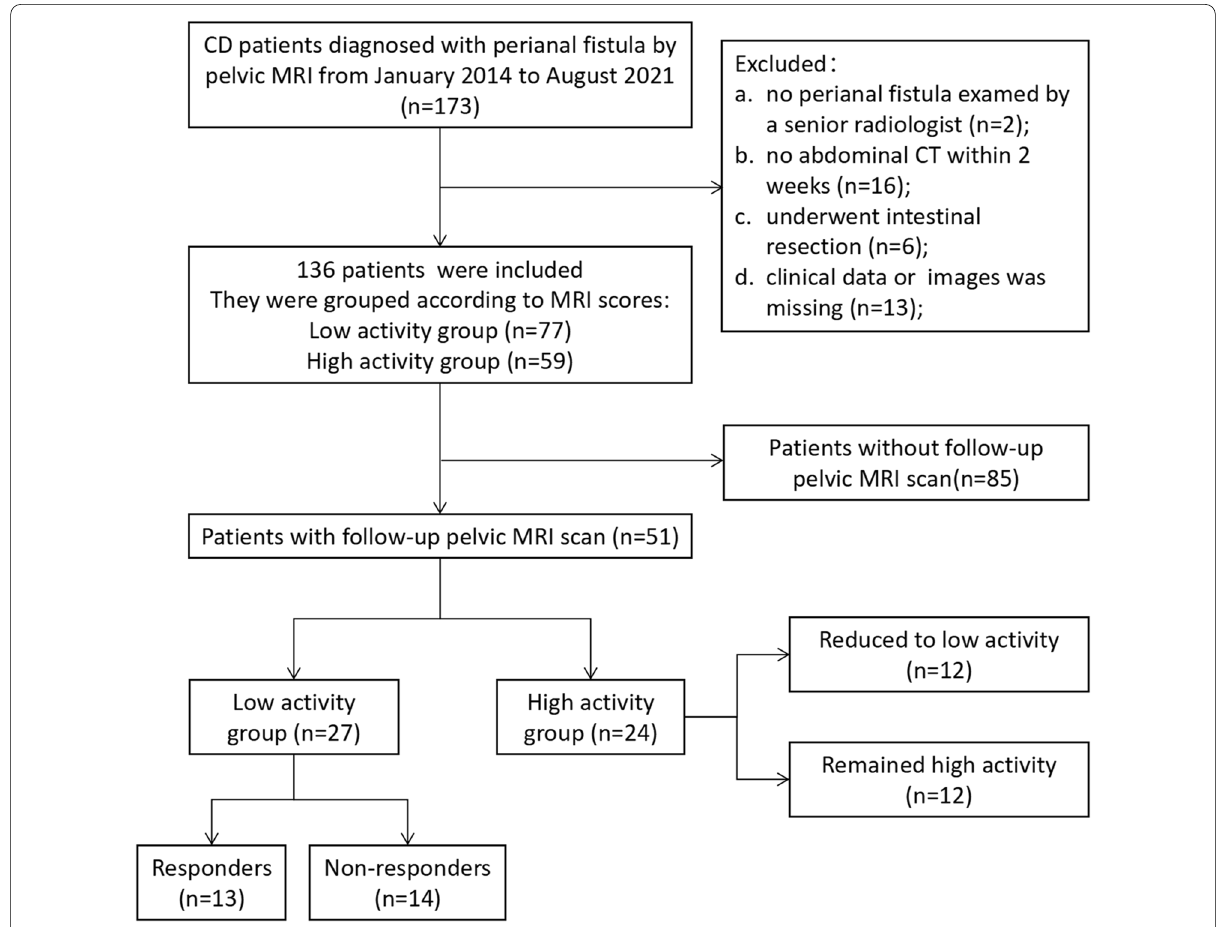
Fig. 1 Flowchart for inclusion of patients with Crohn’s